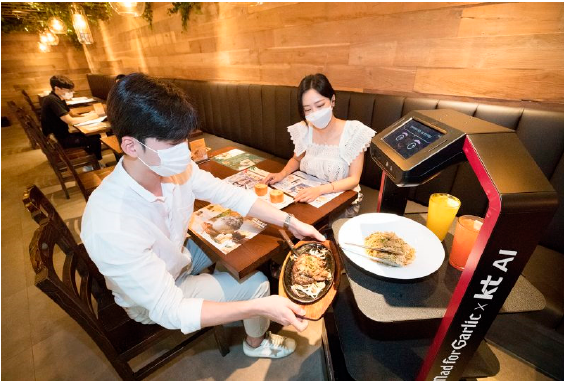
Figure A2. A restaurant where robots provide the services.